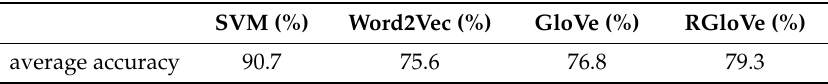
Table 3. Average accuracy of relationship